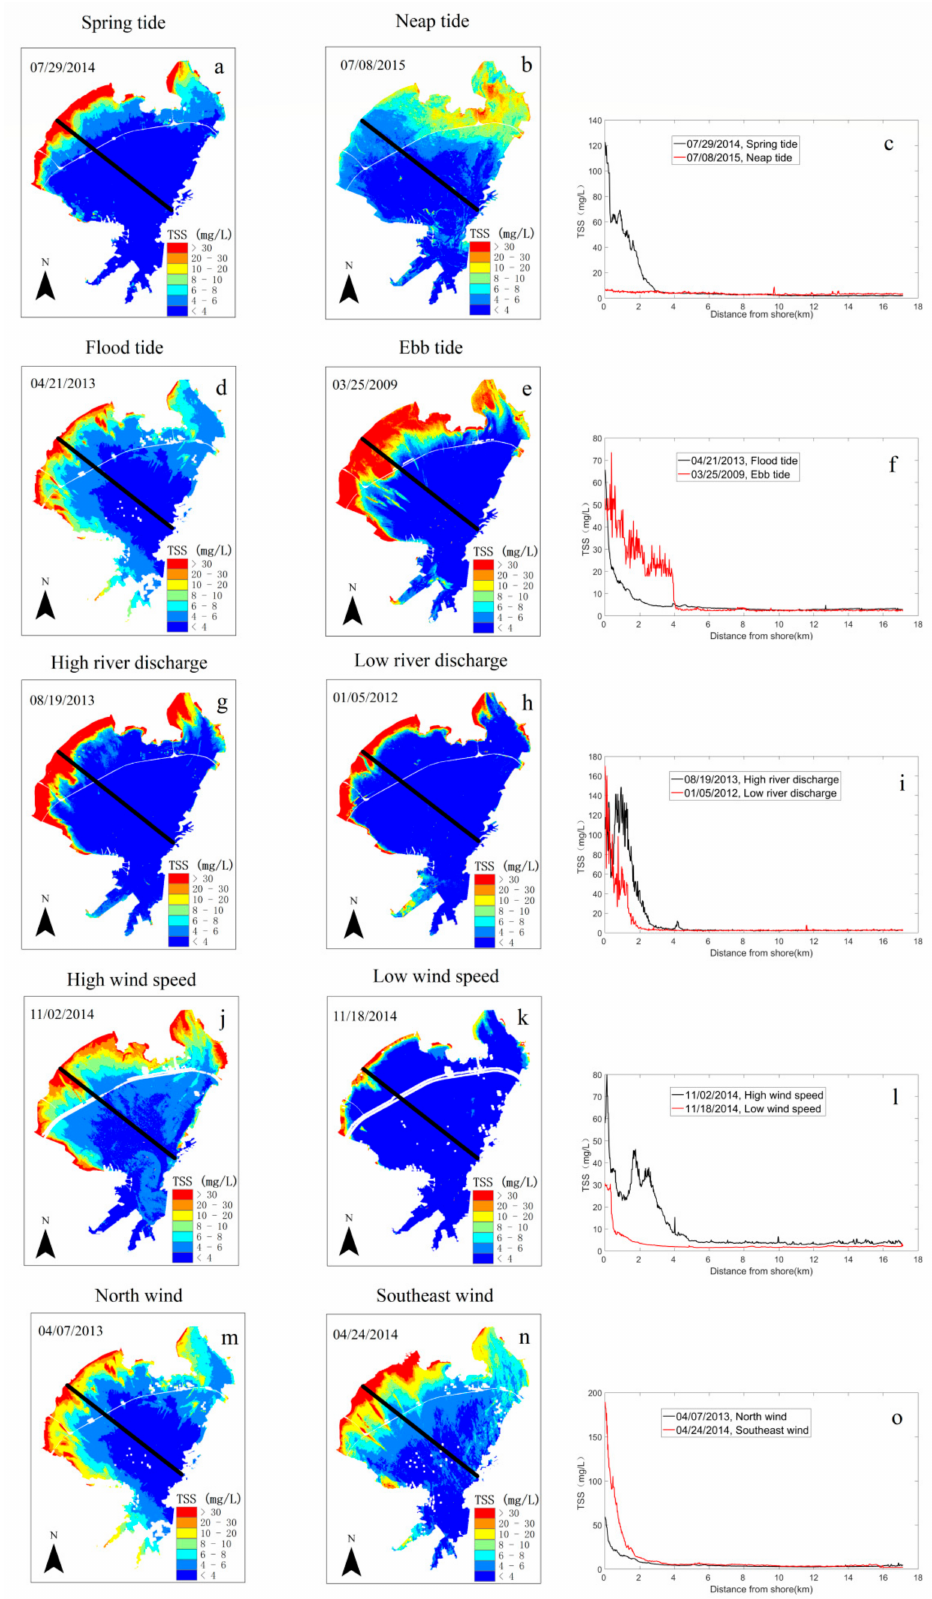
Figure 7. Spatial distribution of TSSs under the control of a sole influence factor and variation of TSSs along the section line: tidal current magnitude ( a – c ); tidal current direction ( d – f ); river discharge ( g – i ); wind speed ( j – l ); wind direction ( m – o ) (The black line is the section